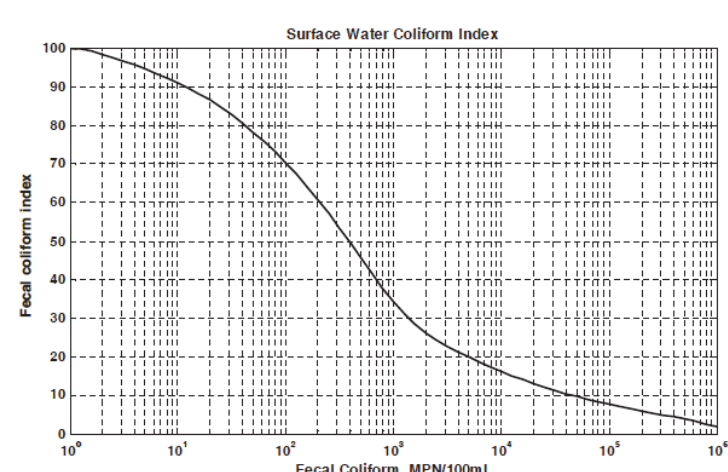
Fig. 2. Fecal coliform (The value of equivalent index is considered 1 for fecal coliform more than 10 MPN/100 ml)